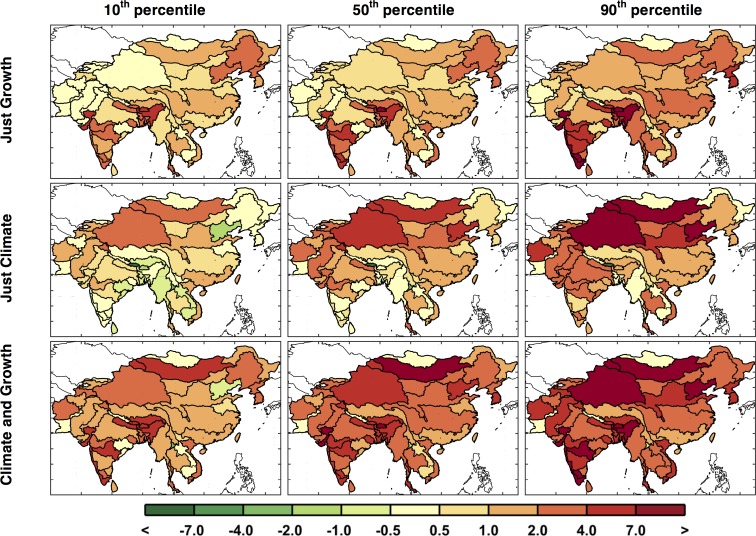
Exceedance changes in ASR UWR (%).Changes are based on the baseline (Fig 6) to the future scenarios averaged over 2041–2050 and shown for the 10th, 50th, and 90th percentiles for each ASR.